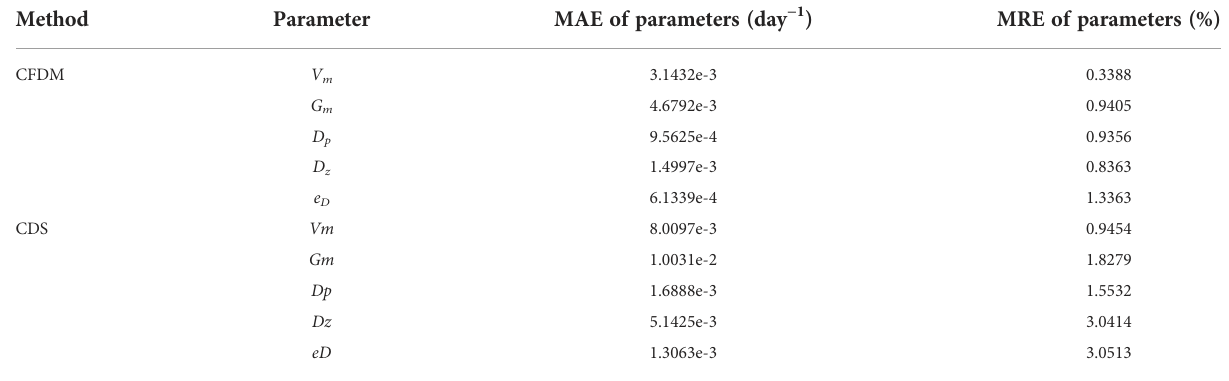
TABLE 5 Same as Table 4 , but for the experiment of Case 1 of optimizing parameters simultaneously.